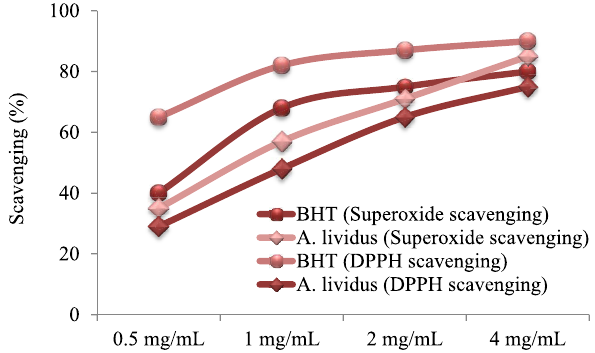
Figure 3. Radical scavenging activity of A. lividus leaf